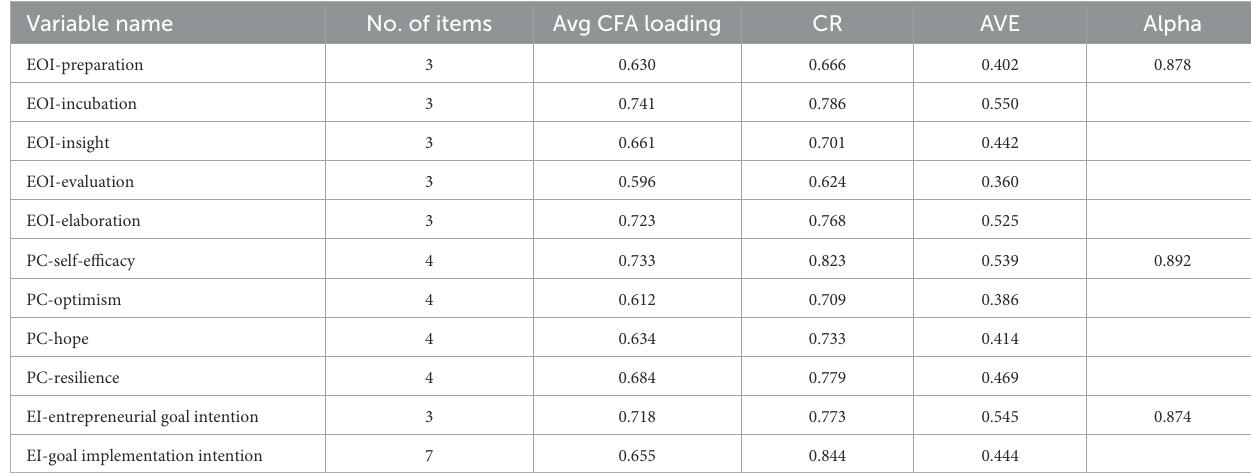
TABLE 2 Reliability of